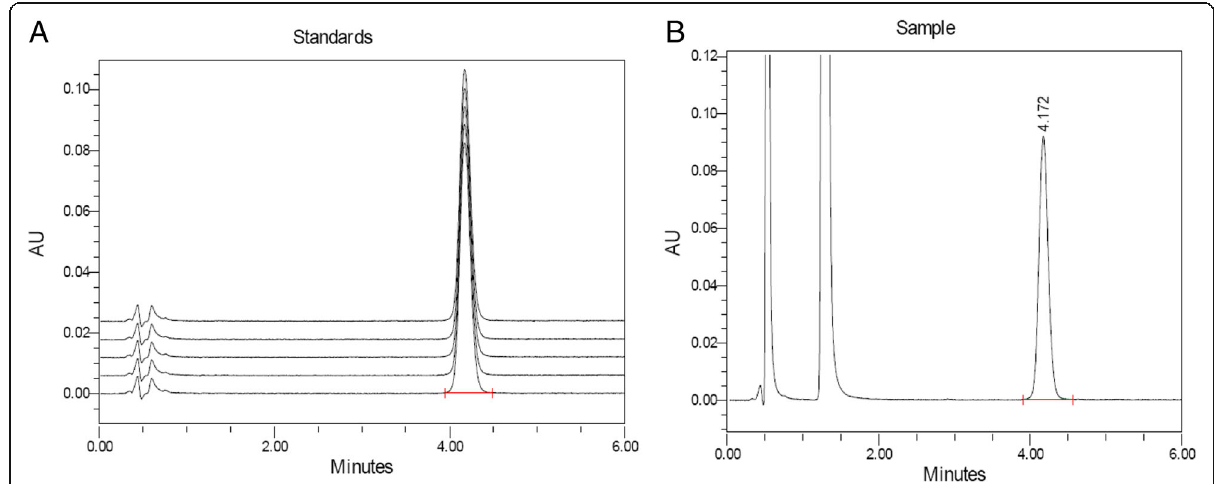
Fig. 2 a Overlaid chromatogram of fulvestrant standard (100 μ g mL − 1 ). b Fulvestrant sample chromatogram (100 μ g mL − 1 )